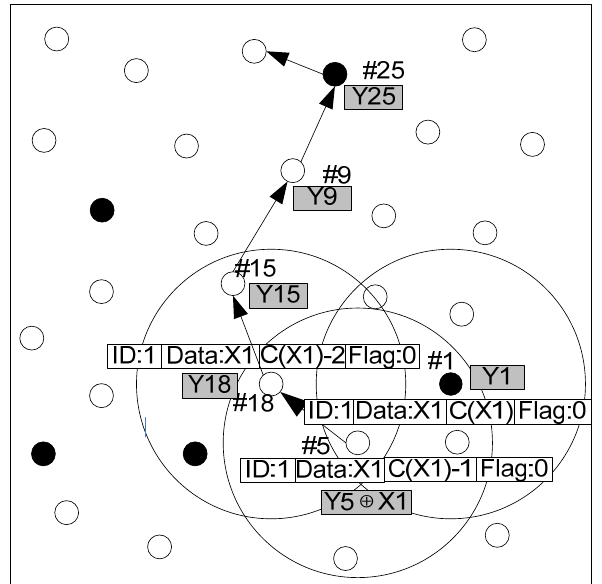
Figure 9. Example of a data packet forwarding in the